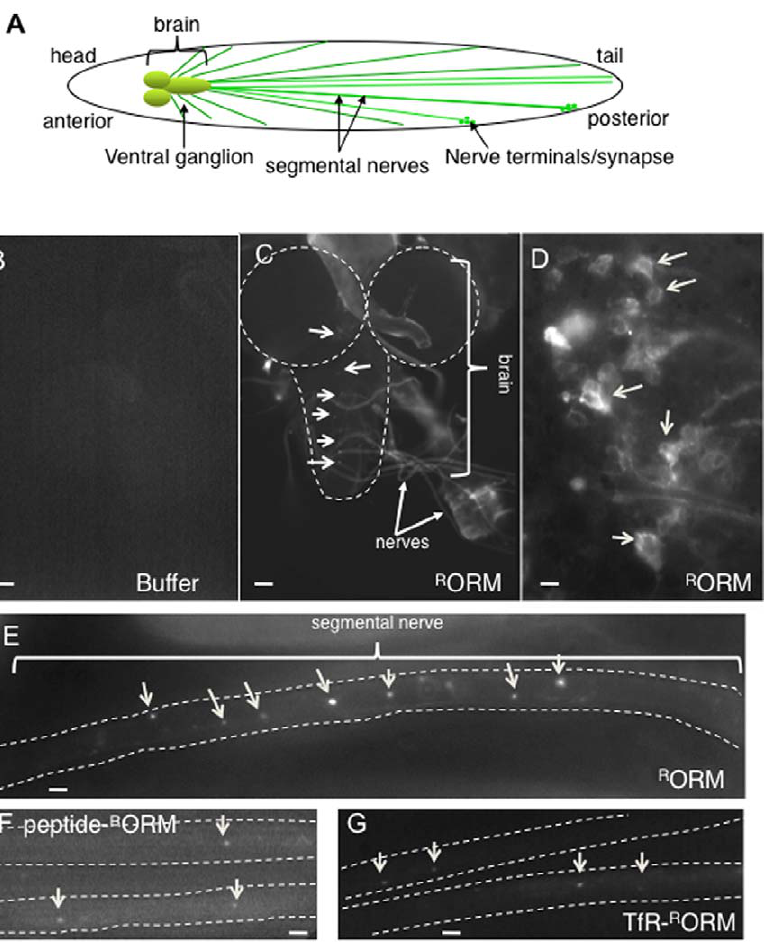
Figure 4. ORMOSIL incorporates into living larval neuronal tissues. (A) A diagram depicting the larval nervous system. The brain is at the anterior. Segmental nerves that originate at the brain extend along the length of the larvae and form synapses or nerve terminals at their ends. Segmental nerves contain bundles of motor and sensory axons, with have their cell bodies located in the brain. (B) Buffer treated larval brain. A representative fluorescence image from a buffer treated larval brain. No fluorescence is observed using the 568 nm filter. Images were taken using the 10 6 objective. Bar=10 m m. (C) ORMOSIL is observed within the larval nervous system. A representative low magnification (20 6 ) light microscopy image of a larval brain (dashed outline) and segmental nerves show incorporation of R ORM particles (arrows). ORMOSIL is observed within the brain (outlined, arrows) and the nerves (arrows). Images were obtained using the 568 nm filter to visualize R ORM. Bar=10 m m. (D) ORMOSIL is observed within the cell bodies of the larval brain. A representative high-magnification fluorescence image using the 100 6 objective from the ventral ganglion region of an ORMOSIL treated larval brain shows that R ORM is incorporated into the cytoplasm of the neuronal cell bodies (arrows). Note that the cell body nuclei are devoid of R ORM and that the fluorescence signal is in a discrete pattern within the cell body (arrows). Bar=5 m m. (E) Unconjugated ORMOSIL is observed within the larval segmental nerve. A representative high magnification fluorescence image using the 100 6 objective from a segmental nerve (outlined) show that R ORM is incorporated into the larval segmental nerve (arrows). R ORM is observed throughout the nerve as bright puncta (arrows). The fluorescence signal we observe can be attributed to accumulated ORMOSIL. Bar=5 m m (F, G) Conjugated ORMOSIL is observed within the larval segmental nerve. A representative high magnification fluorescence image using the 100 6 objective from a segmental nerve (outlined) show that conjugated ORMOSIL (Peptide- R ORM, F, and TfR- R ORM, G) are incorporated into the larval segmental nerves (arrows). Bar=5 m